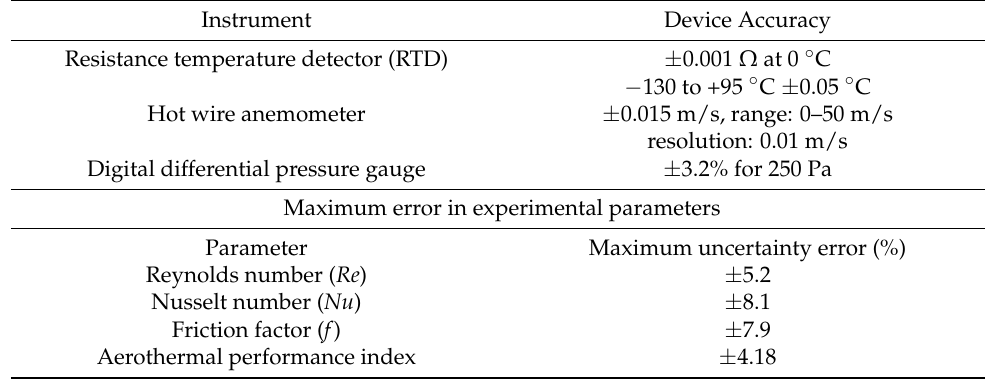
Table 1. The uncertainties in the current experimental